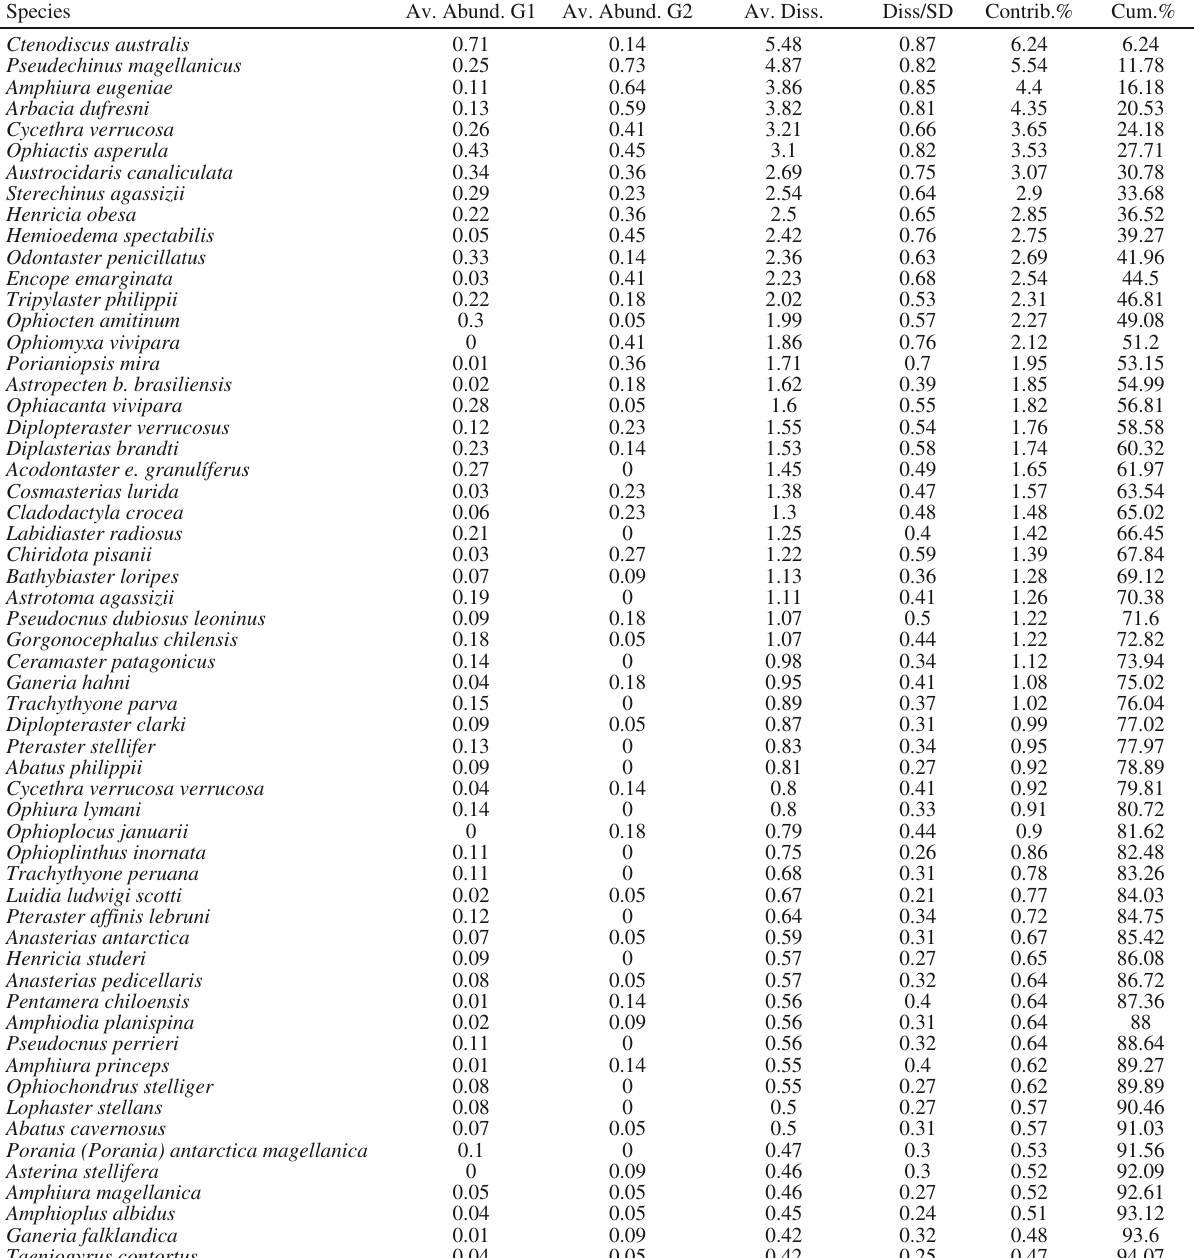
Table 1. – SIMPER analysis results for the data of presence/absence of echinoderm species per square between groups 1 and 2 obtained with cluster analysis. Species are listed according to their contribution to the dissimilarity between groups. Av. Abund., average abundance; Av. Diss., average dissimilarity; Diss/SD, dissimilarity/standard deviation; Contrib.%, percentage of contribution; Cum.%, cumulative percentage.